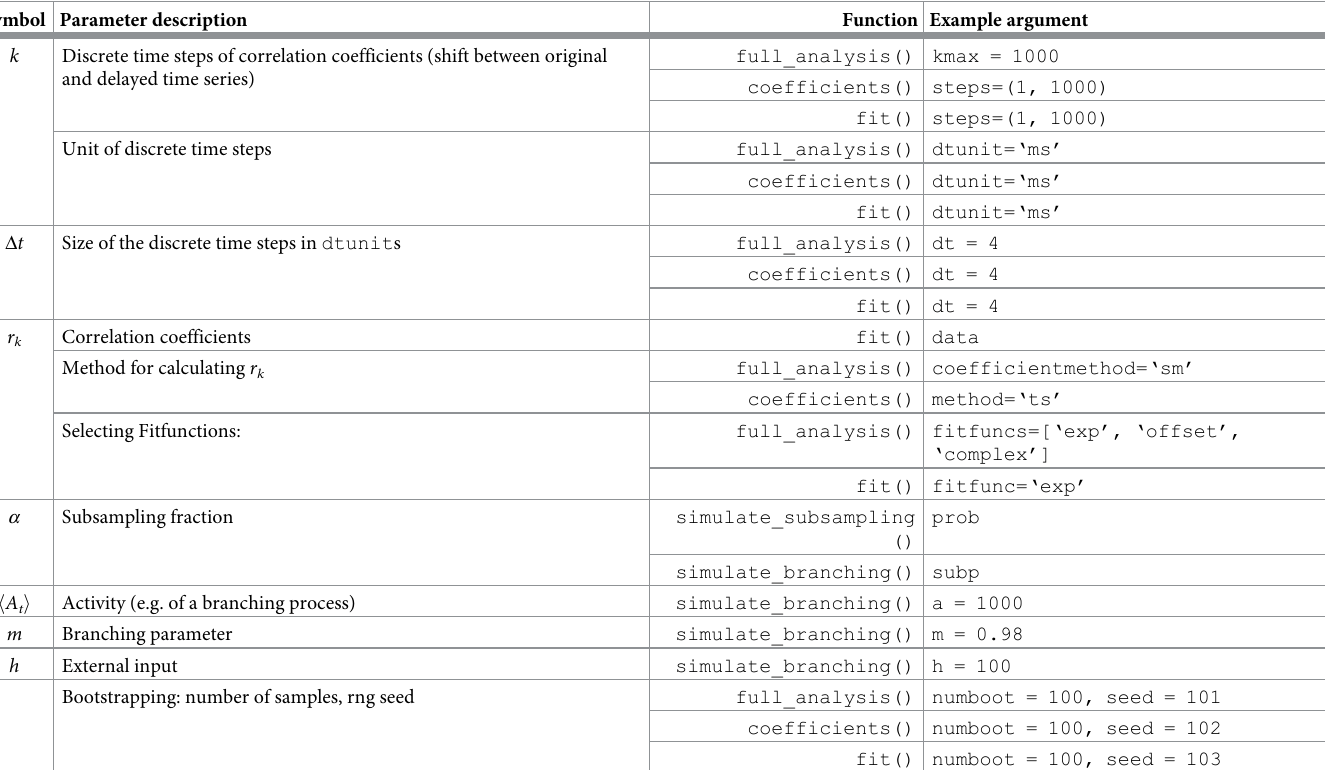
Table 1. List of the most common parameters and functions where they are used. For a full list of each function’s possible arguments, please refer to the online docu- mentation [43]. Symbol Parameter description k Discrete time steps of correlation coefficients (shift between original and delayed time series)